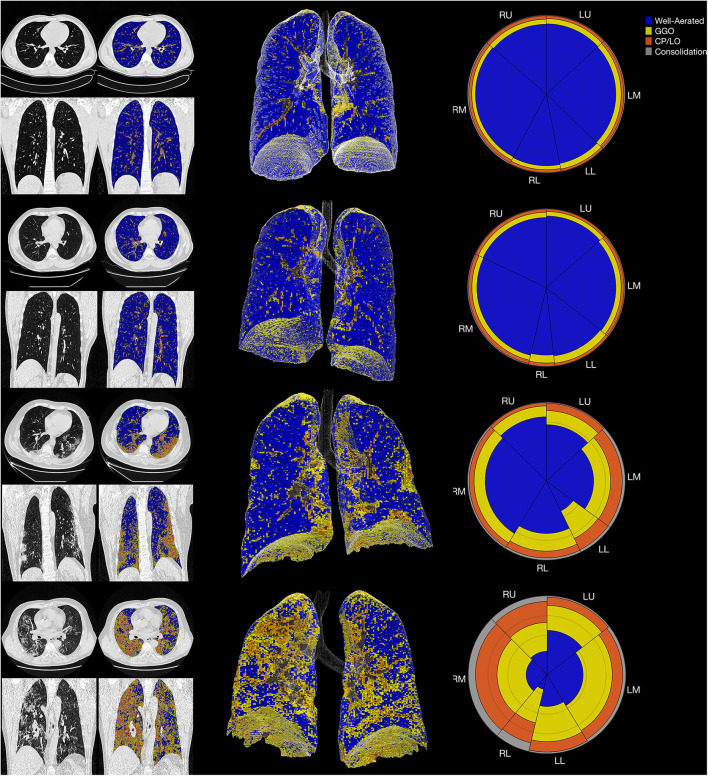
The summary glyph (right column) to the underlying 3D scan data (middle column) and CT images in axial and coronal slices (left column) in a representative case from the control group (row A) and COVID-19 with mild (row B), moderate (row C), and severe (row D) pneumonia involvement. In the glyph (right column), the first letter (R/L) indicates the right and left lung, the second letter (U/M/L) denotes, respectively, the upper, middle, and lower lung zones.